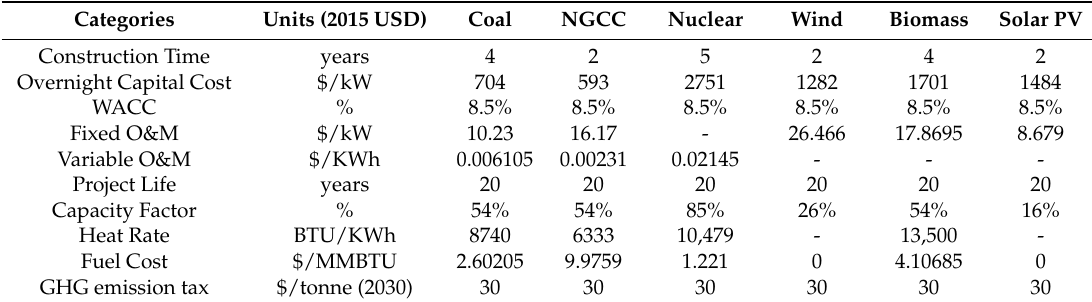
Table 6. Basic assumptions according to [52].